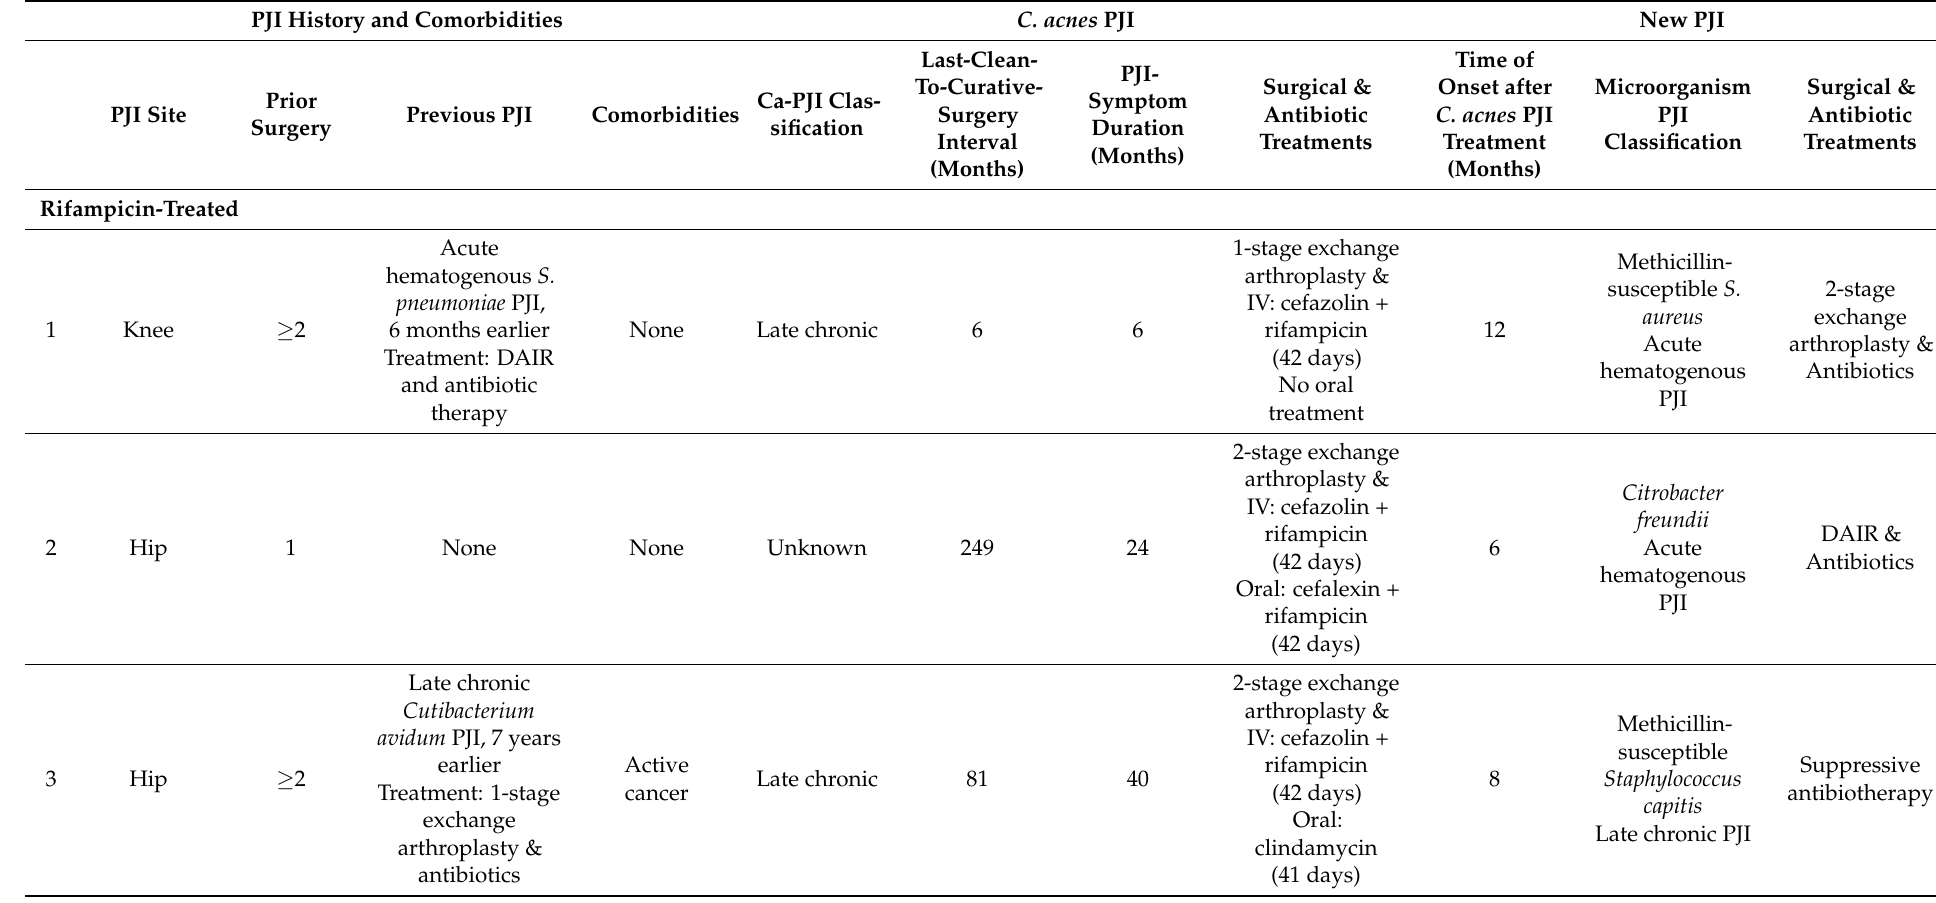
Table 3. Characteristics of the six patients with a new PJI after treatment of C. acnes PJIs with rifampicin or without. PJI History and